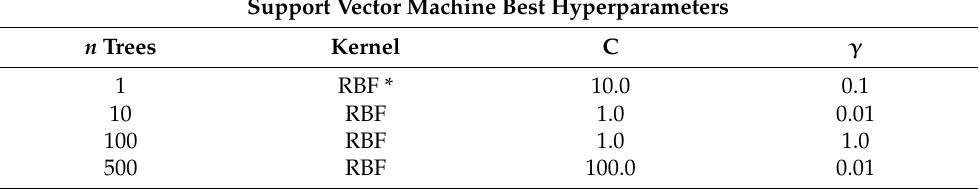
Table 2. Best SVM hyperparameter found by the grid search algorithm when 1, 10, 100 and 500 trees were set.